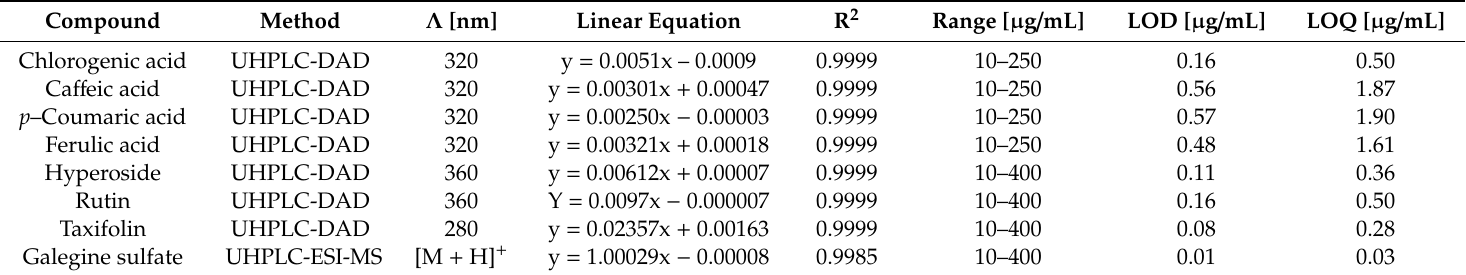
Table 5. Validation parameters of the standard compounds for UHPLC-DAD and UHPLC-ESI-MS